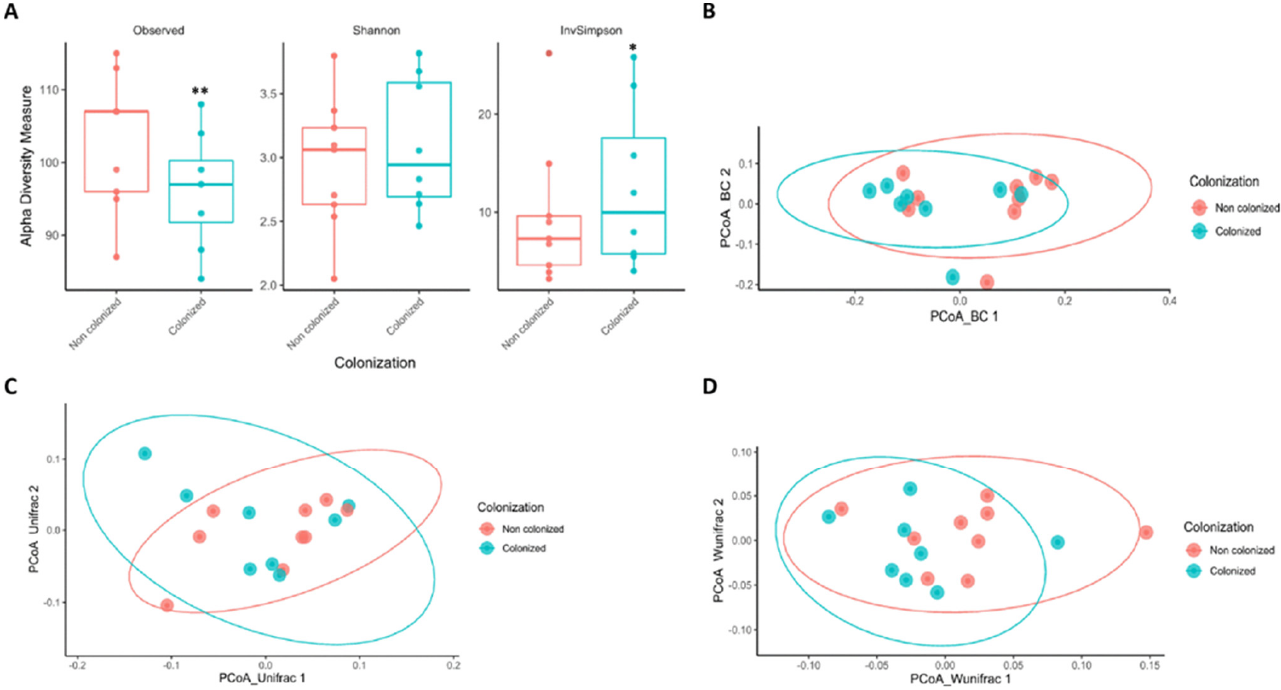
Figure 1. Colonized patients showed differences in gut microbiota richness and evenness compared to non-colonized patients. ( A ) Values of alpha diversity index (Observed features, Shannon, and Inverse Simpson) comparing non-colonized and colonized samples. ( B ) PCoA for Bray–Curtis diversity between non-colonized and colonized samples. ( C ) PCoA for Unifrac distance between non- colonized and colonized samples. ( D ) PCoA for Weighted Unifrac distance between non-colonized and colonized samples. Values are represented as mean ± SD. Significant differences are represented as * = p < 0.05; ** = p < 0.01. Statistical test employed for alpha diversity analysis was t-test and PERMANOVA test for beta diversity.